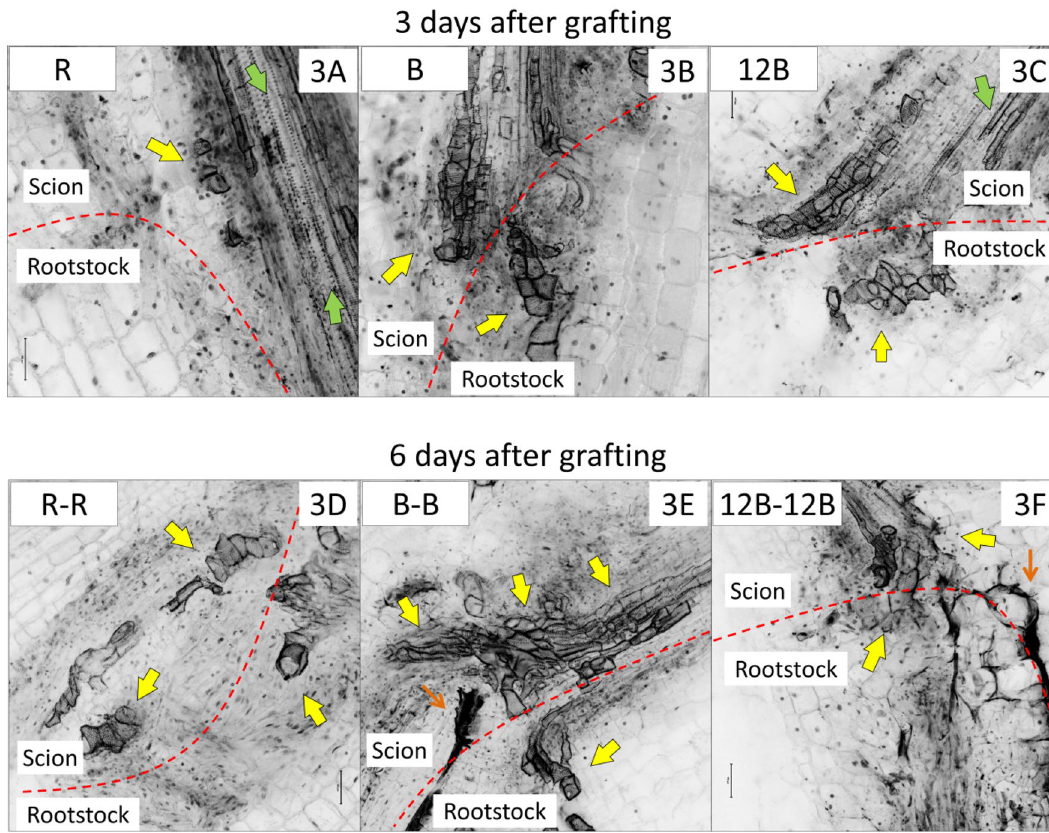
Figure 3. Projections of CLSM sections, depicting the histological organization at the grafting junction of grafted watermelon seedlings after three (upper line) or six (bottom line) days in the healing chamber under three light treatments. In all the CLSM figures, fluorescence intensity has been inverted (negative image) for better visualization. Red dashed lines indicate the grafting junction line. Yellow arrows indicate newly formed vessels which derived from redifferentiated parenchymatic cells. Green arrows indicate initial xylem vessels. Thin orange arrows indicate wound cork that was formed at some sites of the